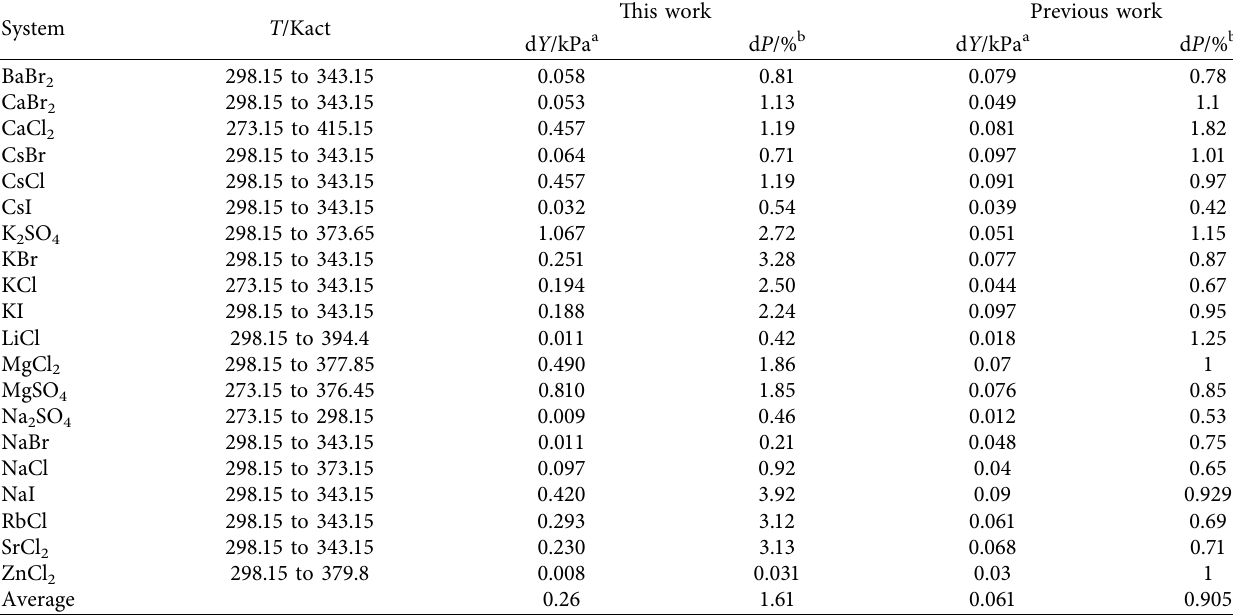
Table 8: Calculations for VLE